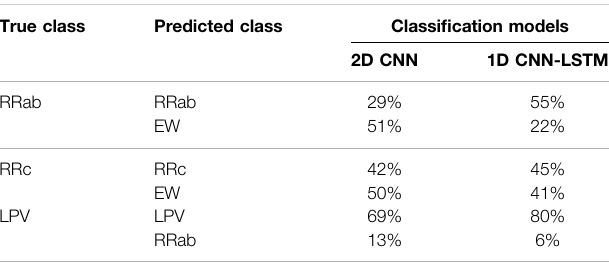
TABLE4| Comparisonofclassi fi cationresultsforthreevariabilityclassesfromthe CRTS dataset using 2D CNN and 1D CNN-LSTM models. The two rows for each true class represent the correct classi fi cation (to the actual class) and mis- classi fi cation (to the other class indicated in the second row) percentages,